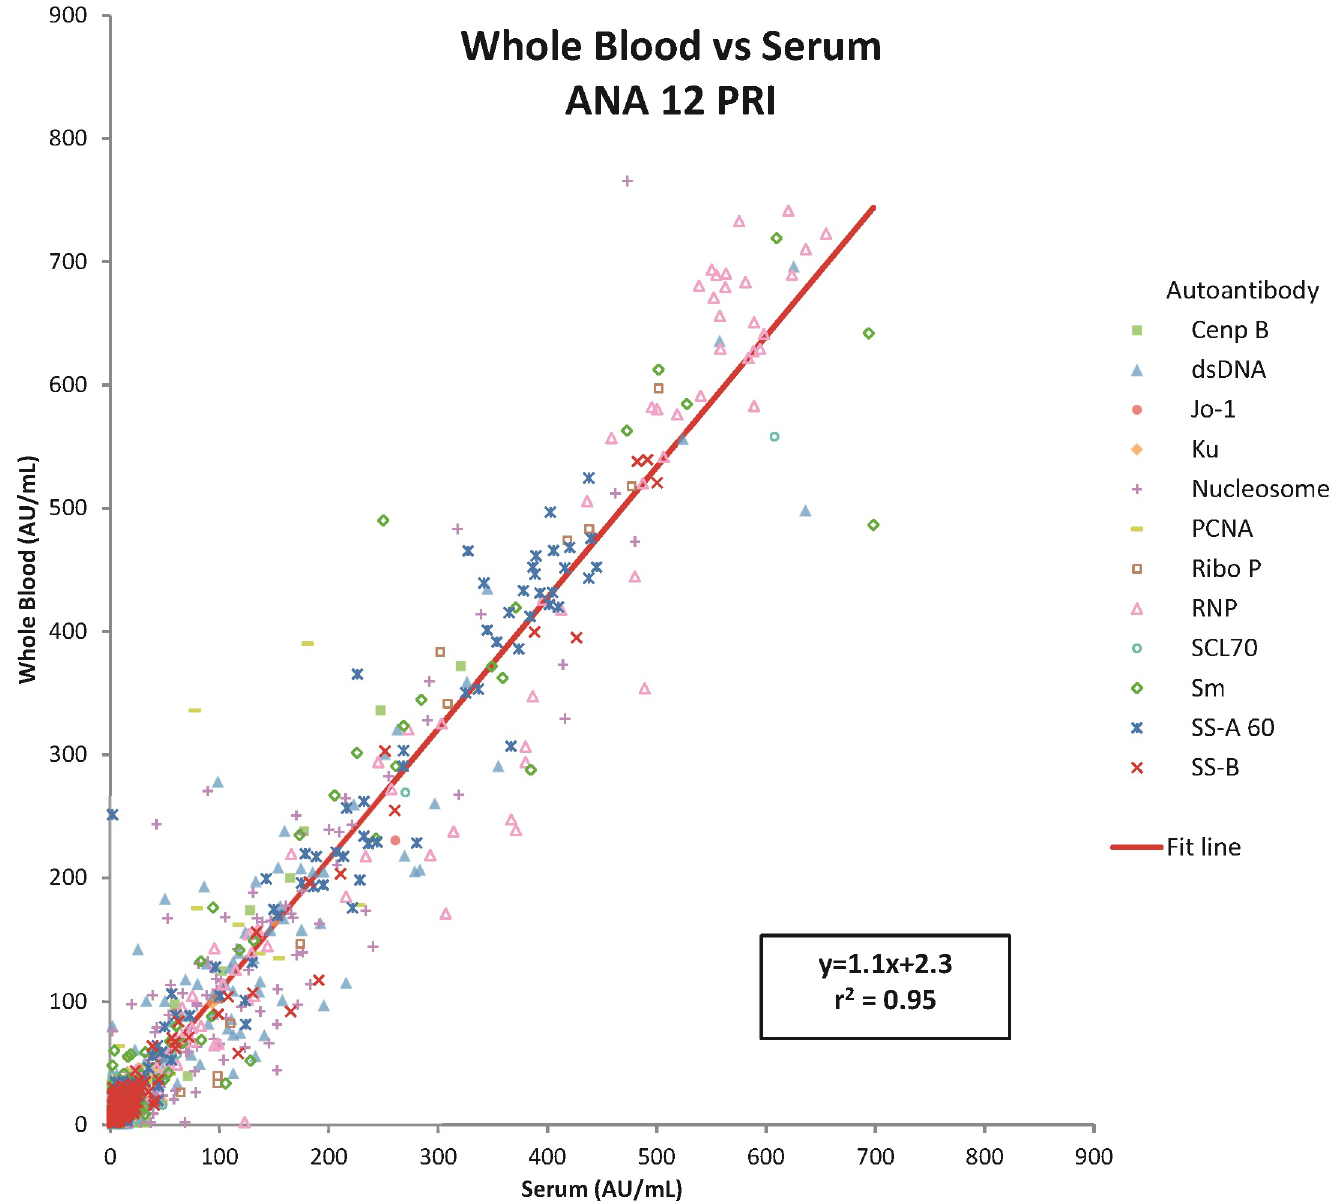
Fig 1. Combined whole blood vs serum